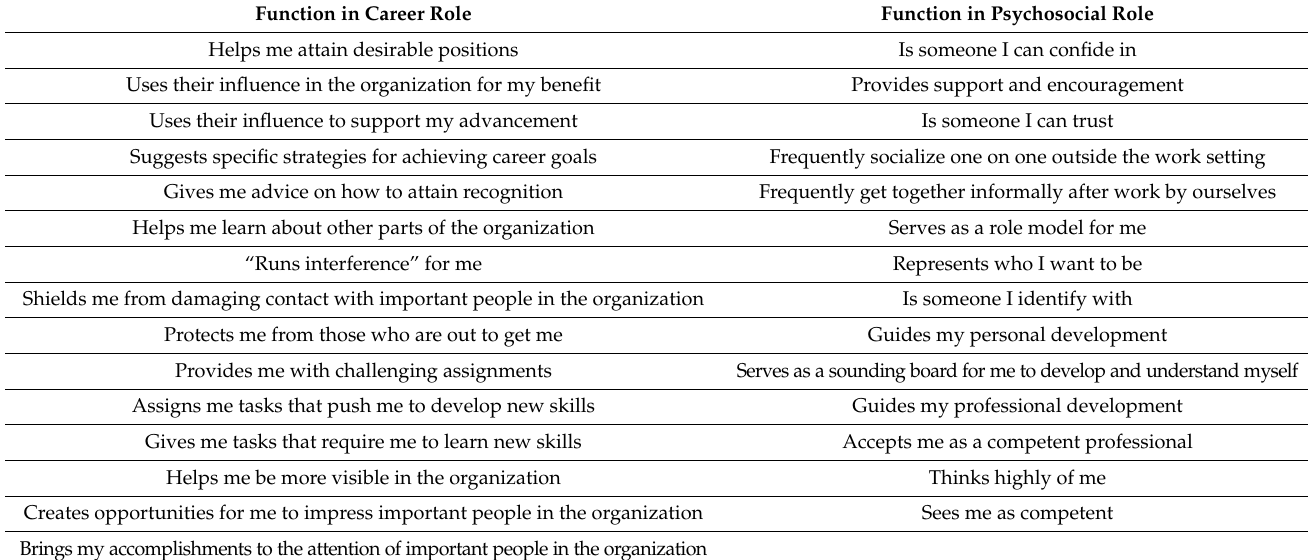
Table 1. Kram’s roles of mentors